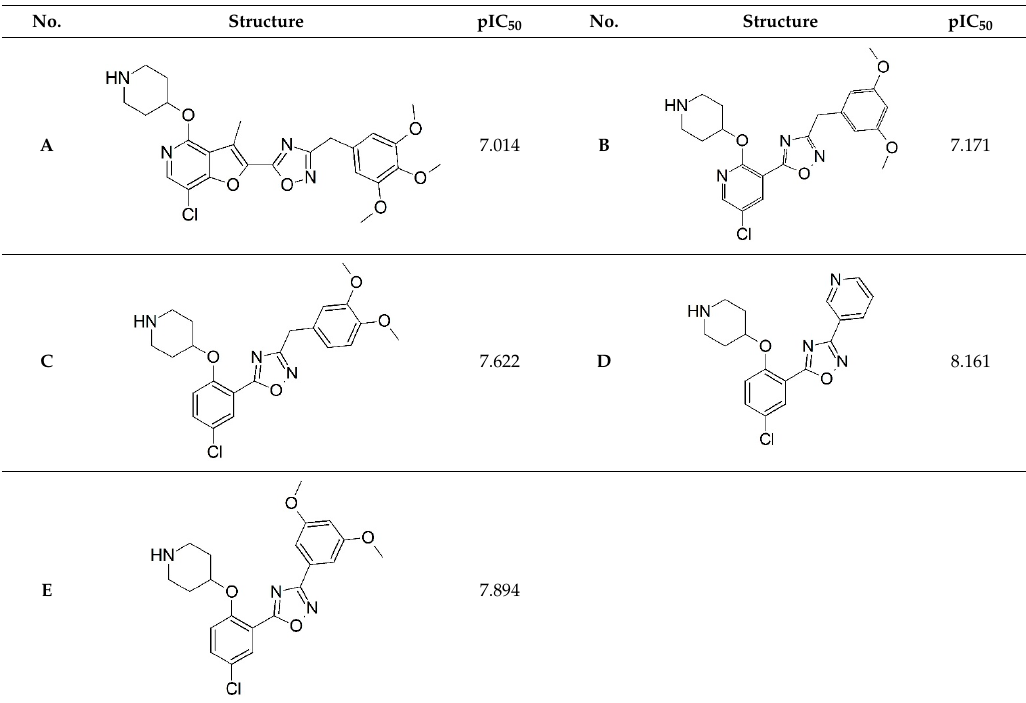
Table 3. Structures of the compounds proposed and the predicted pIC 50 values based on Model B3.